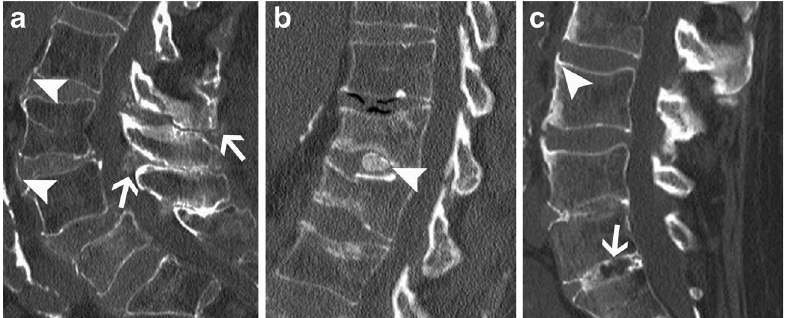
Fig.14 Disc calcifications.Sagittal CTimagesofthe lumbar spine shows ( a ) calcium pyrophosphate dehydrate (CPPD) crystal deposition (arrowheads in a), ( b ) hydroxyapatite crystal deposition (arrowhead in b) and ( c ) syndesmophytes (arrowhead, in c) in three different patients. Note calcifications in ligamentum flavum and interspinous